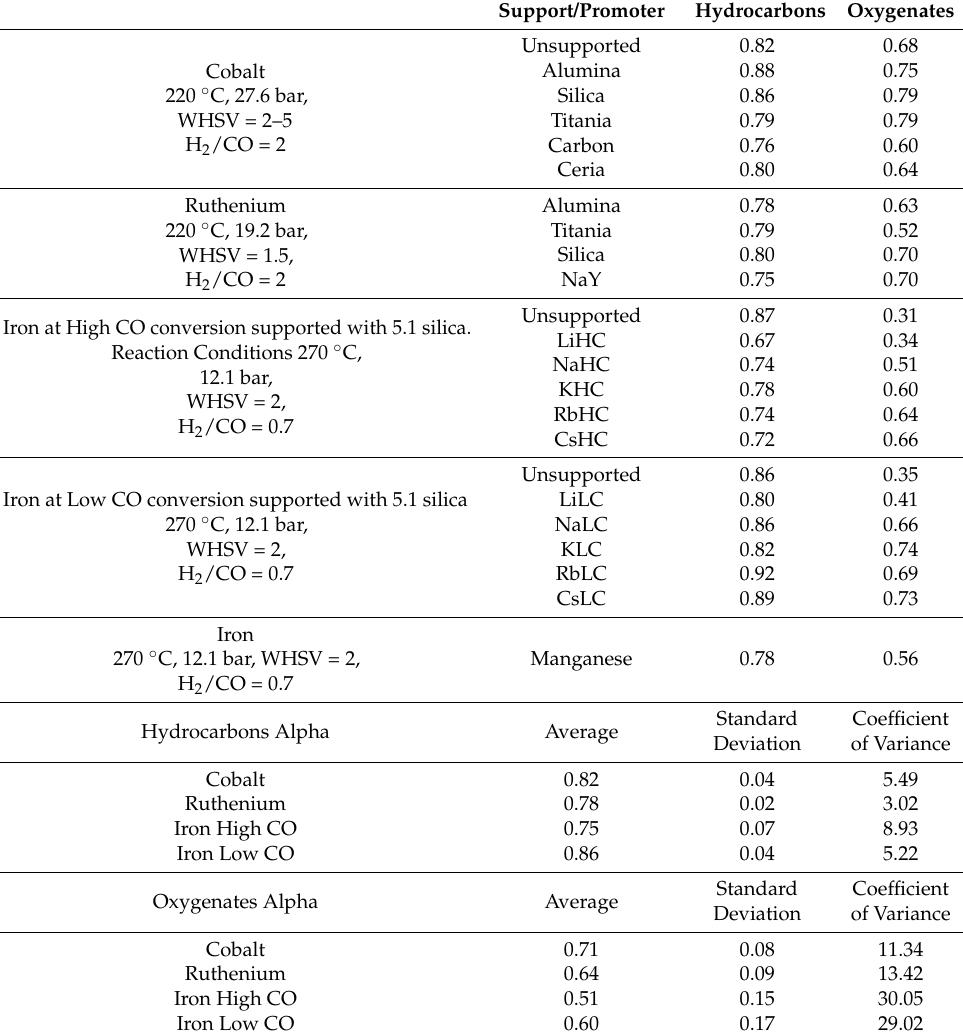
Table 1. Alpha ( α ) as compared across several FT synthesis